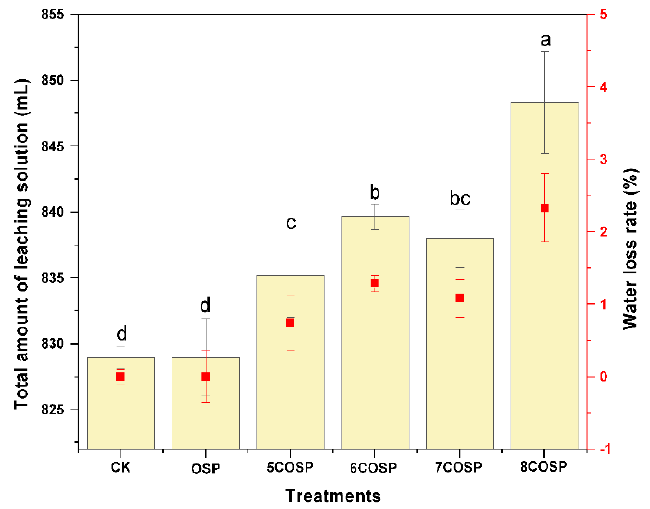
Figure 10 . Cumulative volume and loss rate of leachate under the treatments. CK: Urea treatment with N application level of 200 mg/kg; OSP: 0.2 wt.% OSP; 5–8COSP: 0.2 wt.% OSP calcined at various temperatures; particle size of the OSP and four COSPs = 0.15 mm. The different letters in the same column indicate that the differences were statistically significant at the p < 0.05 level.